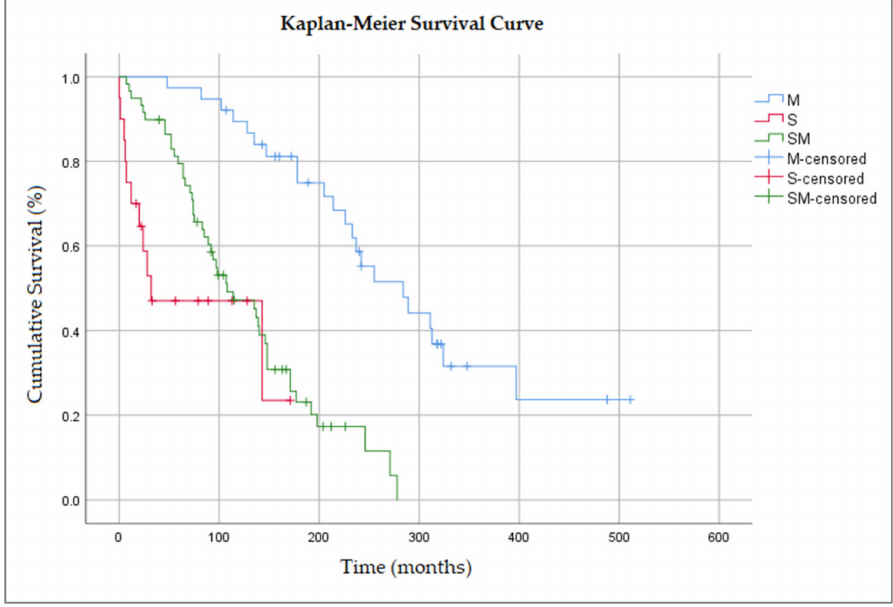
Figure 2. Kaplan–Meier survival curves comparing the overall survival in MPM tumor